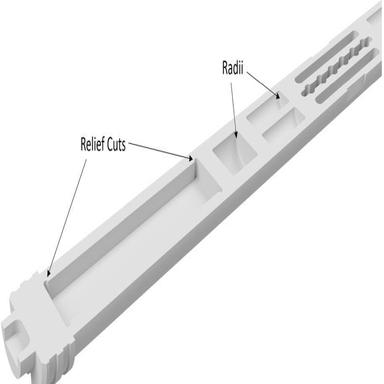
Schematic of the standard capsule fixture with relief cuts and radii to decrease fabrication difficulty.